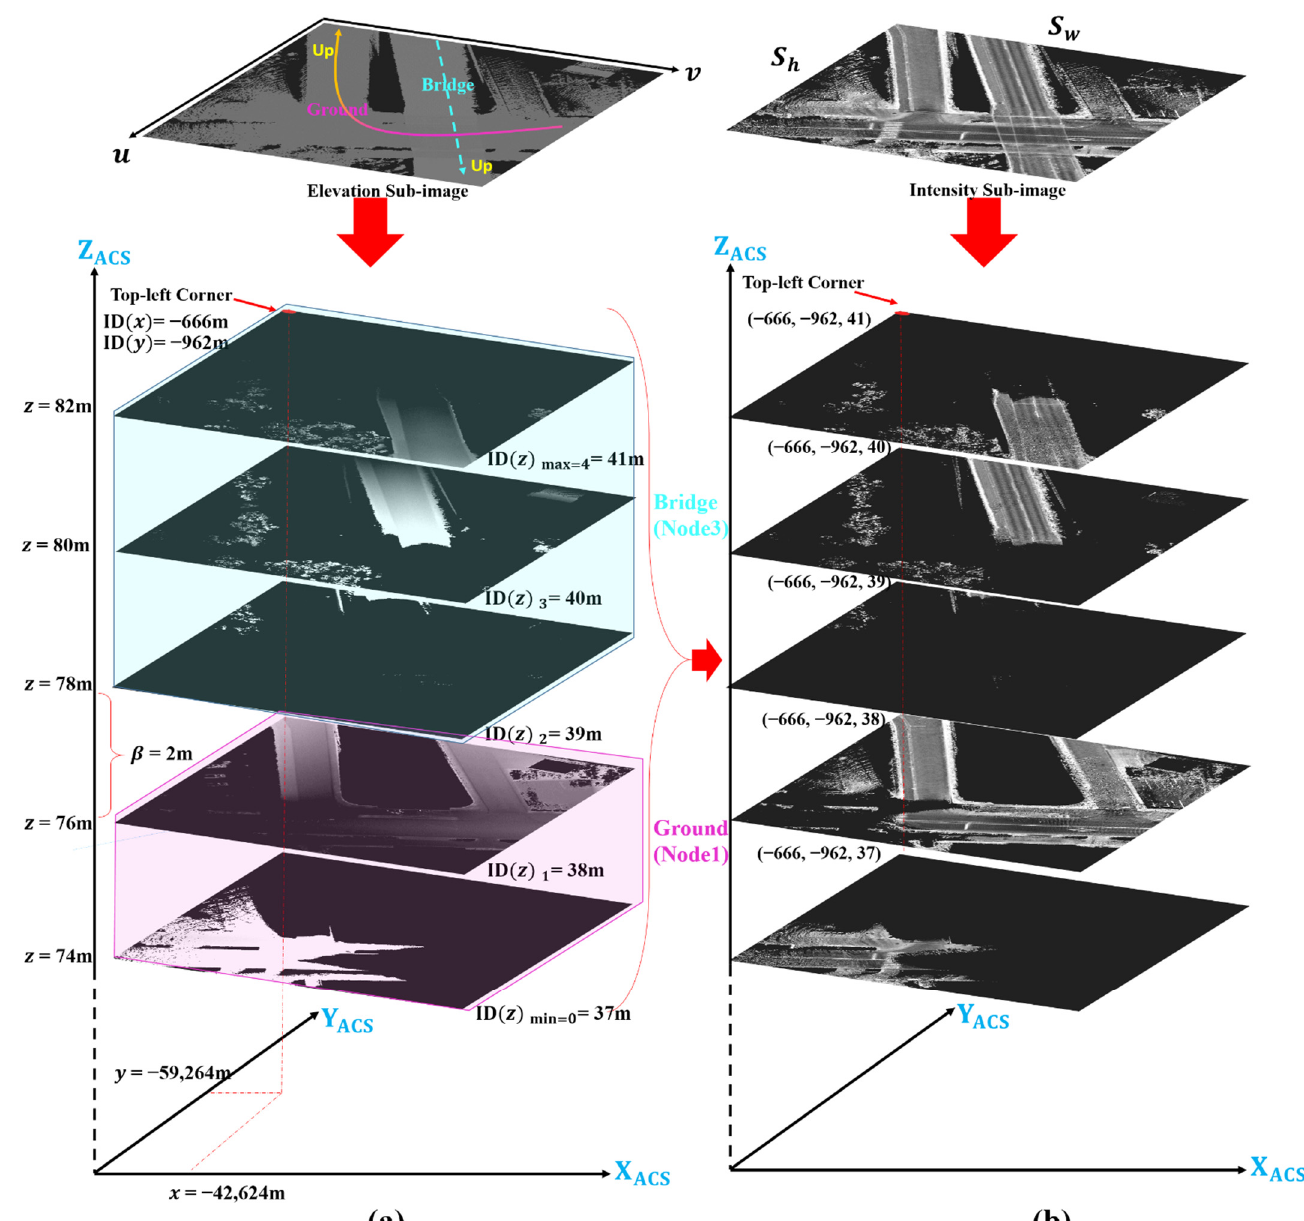
Figure 4. Ground and bridge road structure shown in Figure 3 are mapped according to LSM. ( a ) The elevation image of the ground road surface is first encoded and divided into two layers in the pink polygon. The map is then extended in the Z direction based on the Z-IDs to contain the bridge layer images. ( b ) The corresponding intensity images are created according to the pixel distribution in the layered elevation images in ( a ).